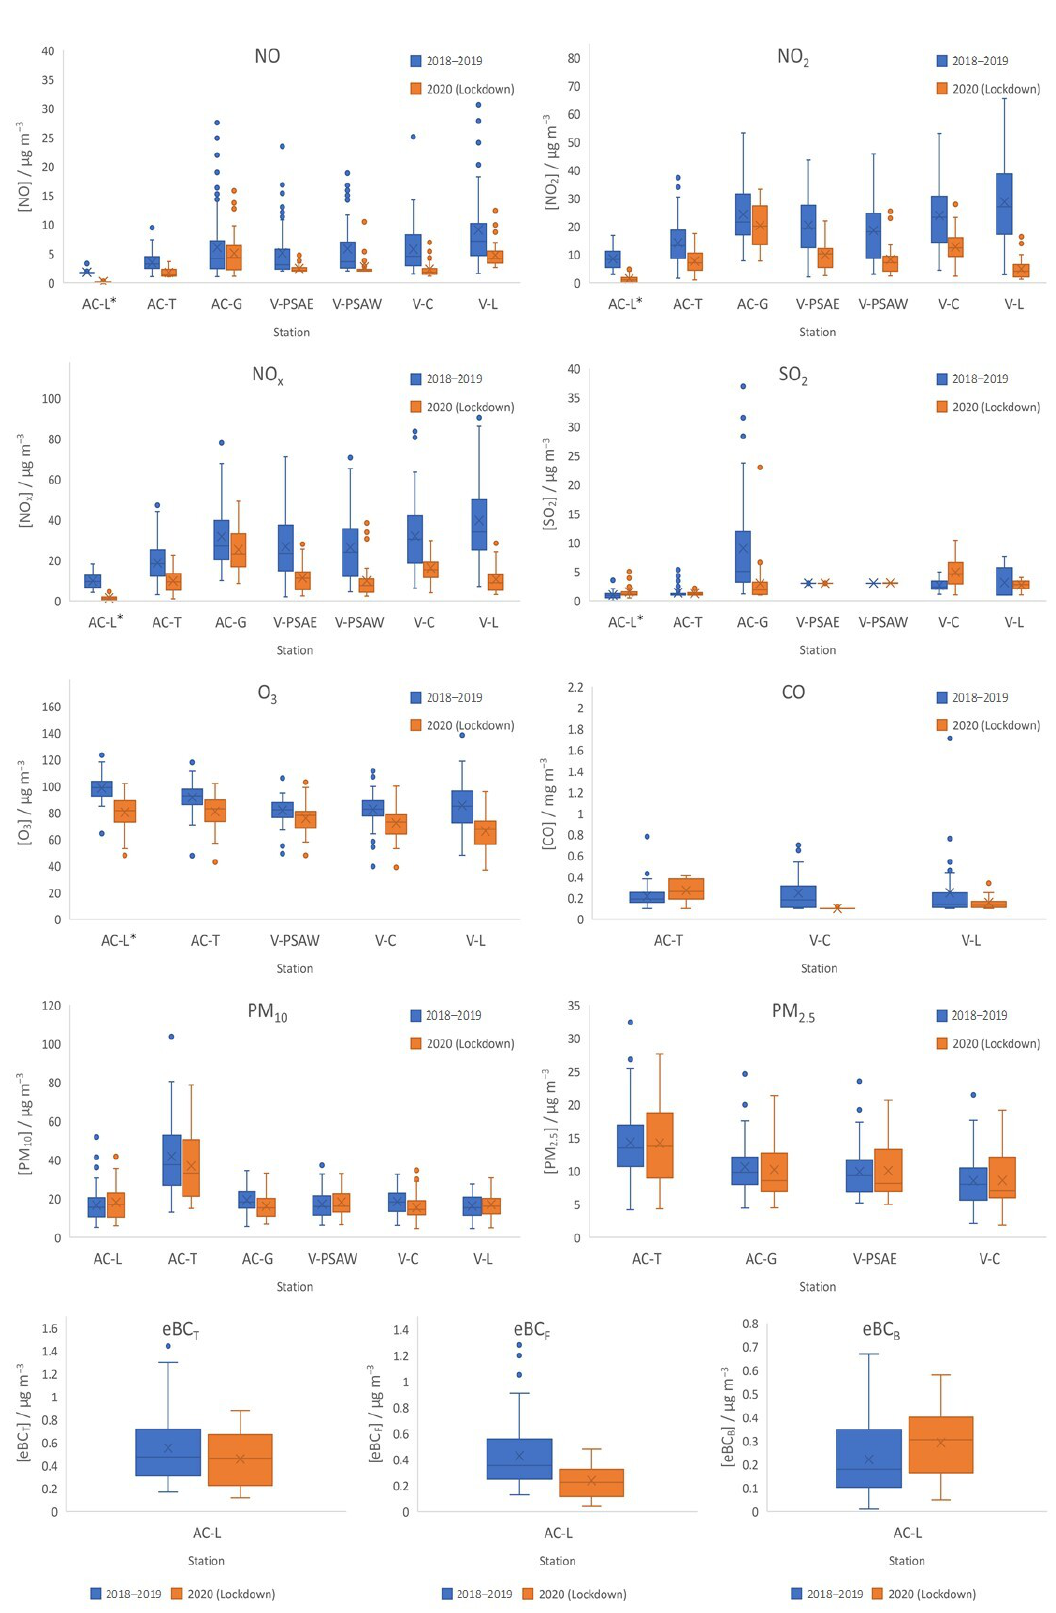
Figure 5. The comparison of NO, NO 2 , NO x , SO 2 , CO, O 3 , PM 10 , PM 2.5 , eBC T , eBC F , and eBC B levels during the lockdown (2020) and the same period in the previous two years (2018–2019). The upper and lower boundaries of boxes indicate the 75th and 25th percentiles, respectively; the line within the box marks the median; the X marks the mean; the whiskers above and below the boxes indicate the largest and smallest nonoutlier values, respectively. Outliers (dots) refer to values further than 1.5 times the box length from either end of the box. * Only 2019 data